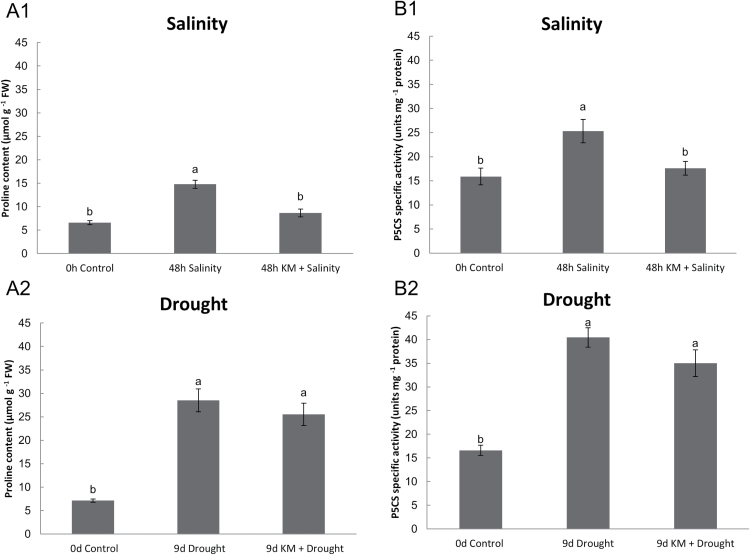
(A) Proline content and (B) P5CS (Δ1‐pyrroline‐5‐carboxylate synthetase) enzymatic activity measurements in salinity‐stressed (A1, B1) and drought-stressed (A2, B2) M. truncatula plants in the absence or presence of 10‐8 M KM pre‐treatment.